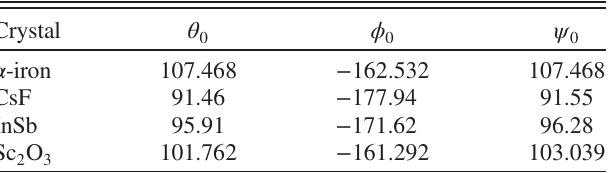
TABLE I. The angles θ 0 , ϕ 0 of a spherical coordinate system together with the angle ψ 0 , which determine the direction of emission and the orientation of the crystal with respect to the particle velocity (see Fig.